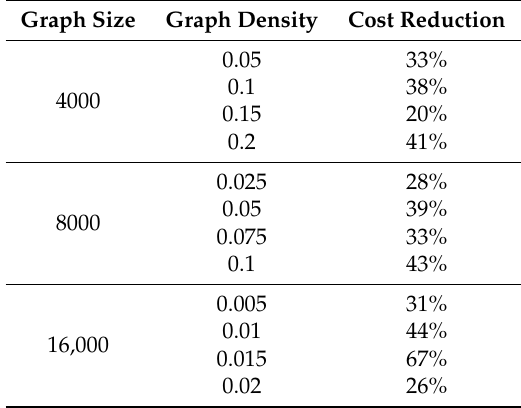
Table 1. Cost reduction on large graphs with different